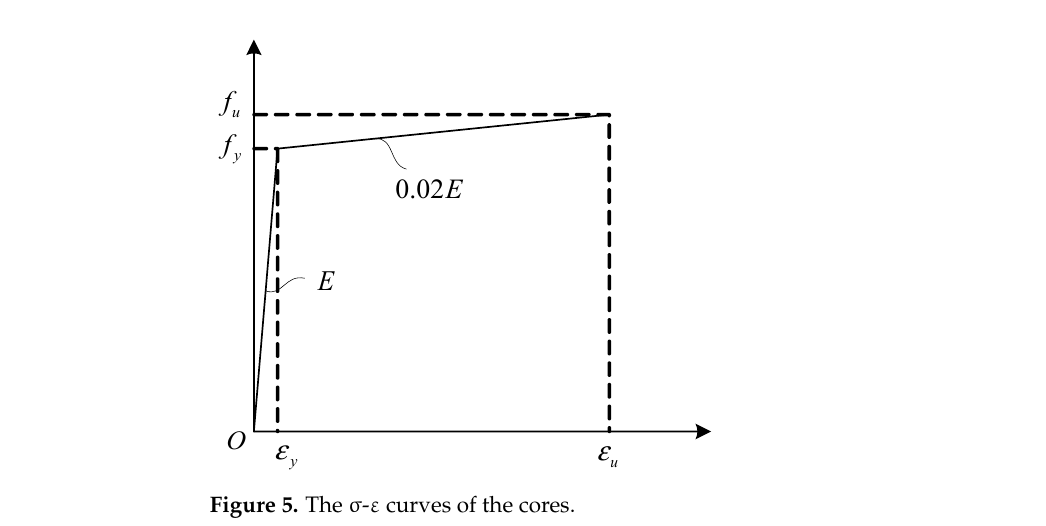
Figure 5. The σ - ε curves of the cores.